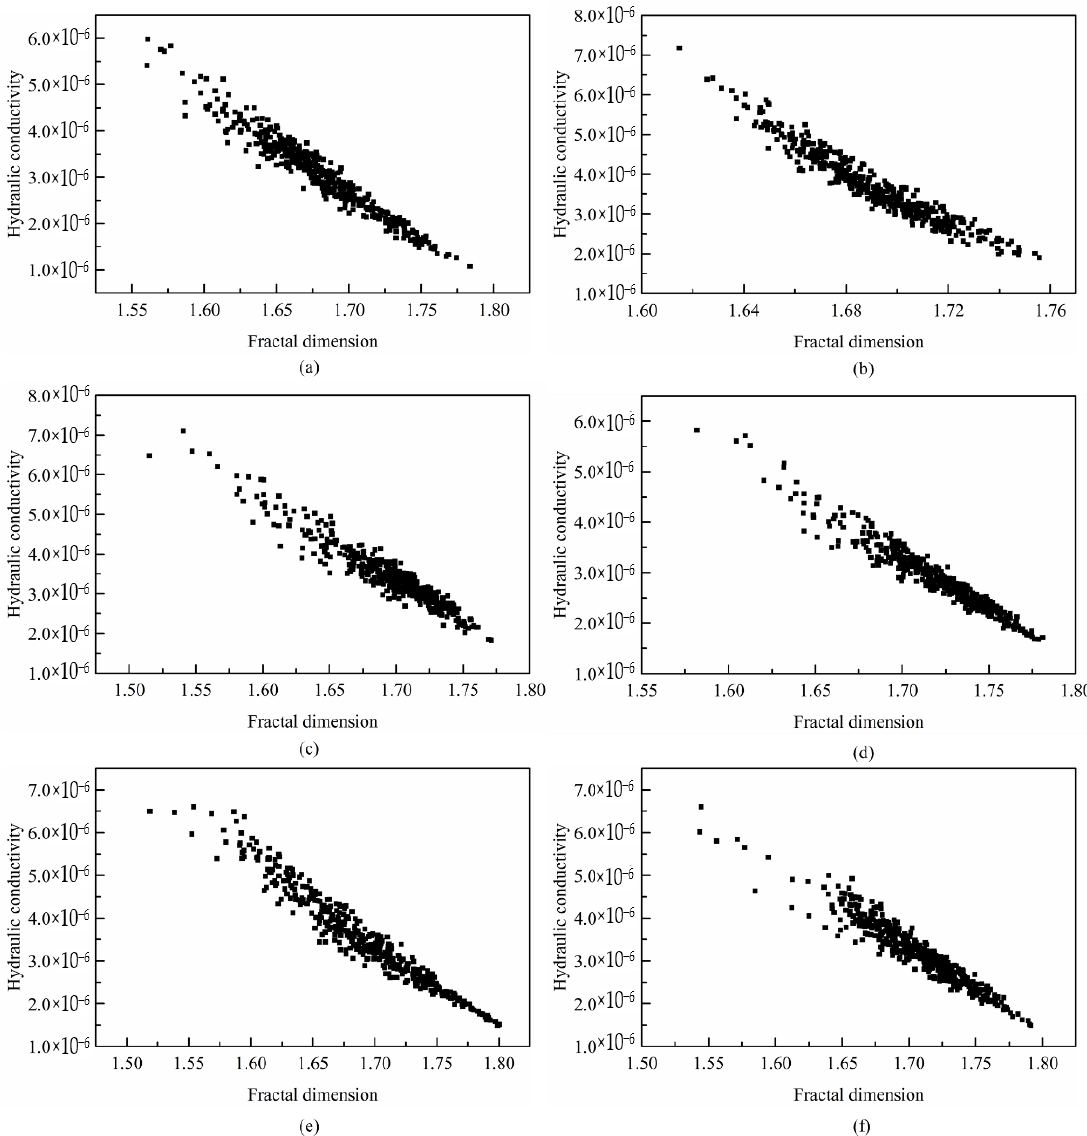
Figure 5. Variation in the hydraulic conductivity with fractal dimension in different sections: ( a ) section 1; ( b ) section 2; ( c ) section 3; ( d ) section 4; ( e ) section 5; ( f ) section 6. 6 ×10 − 6